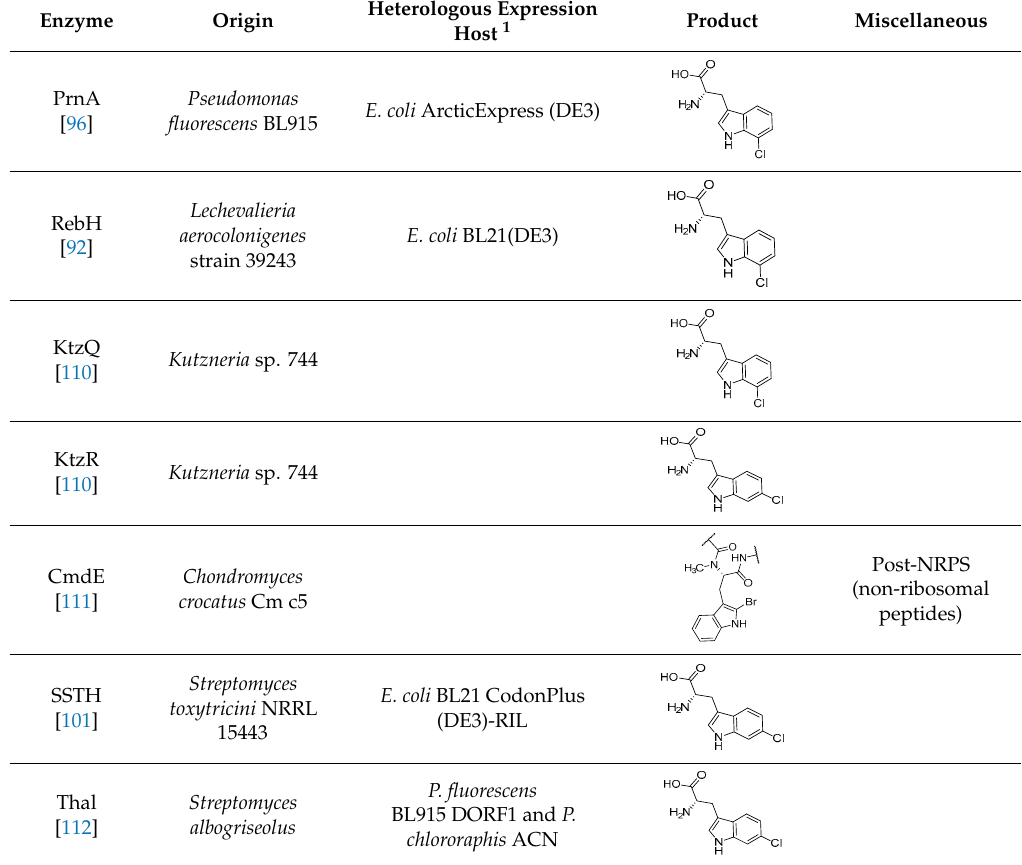
Table 3. Examples of flavin-dependent tryptophan, pyrrole and phenol halogenases that can be carrier-dependent or independent.